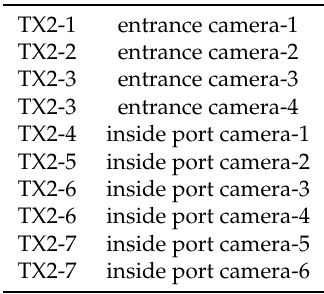
Table 7. Deployment of cameras and TX2s.